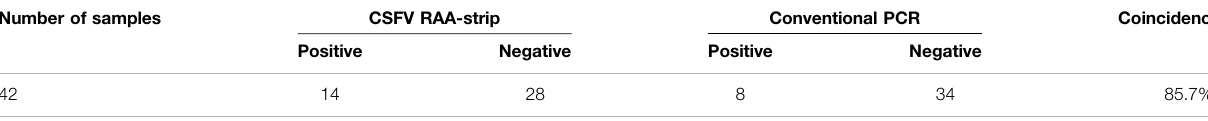
TABLE 4 | Comparison of CSFV RAA-strip and conventional PCR in clinical samples. Number of samples